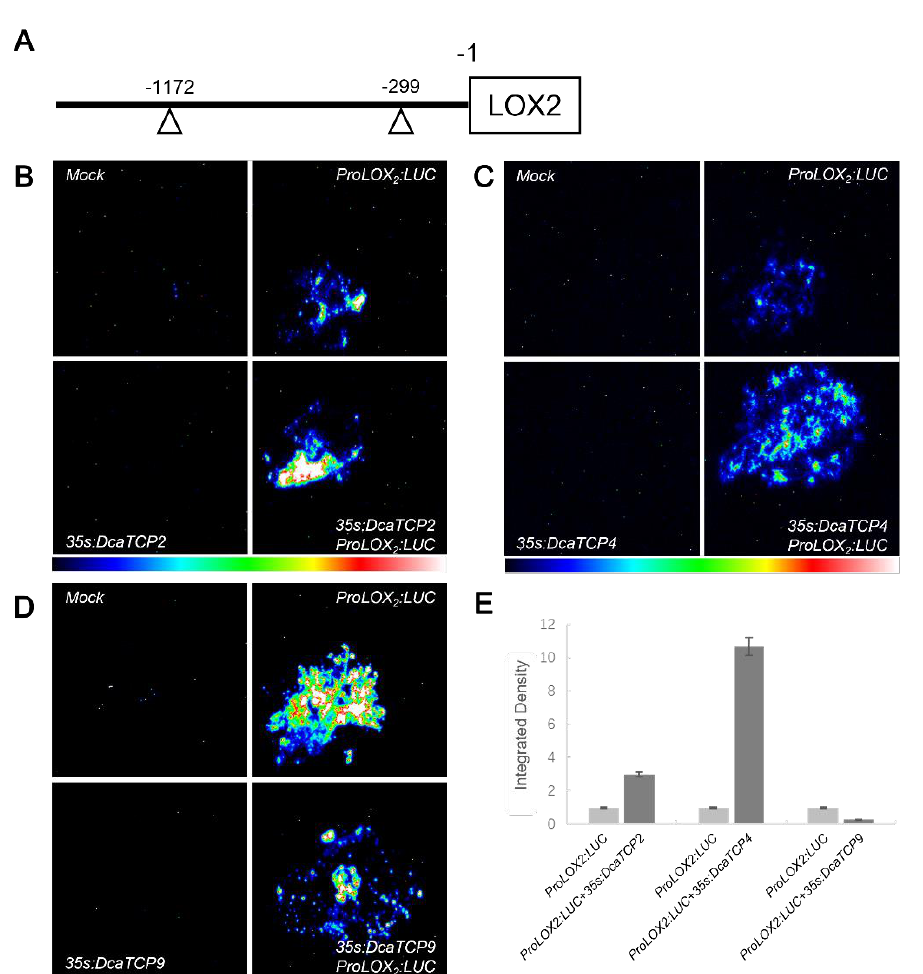
Figure 5. Transient expression analysis of DcaTCP2, DcaTCP4 and DcaTCP9 activities. ( A ) Schematic of the location of TCP-binding motif in the promoter of LOX2 gene. ( B ) LOX2 was activated by DcaTCP2. ( C ) LOX2 was activated by DcaTCP4. ( D ) LOX2 was repressed by DcaTCP9. ( E ) Quantification of relative luminescence intensities in ( B – D ) (mean ± SD, n = 5).